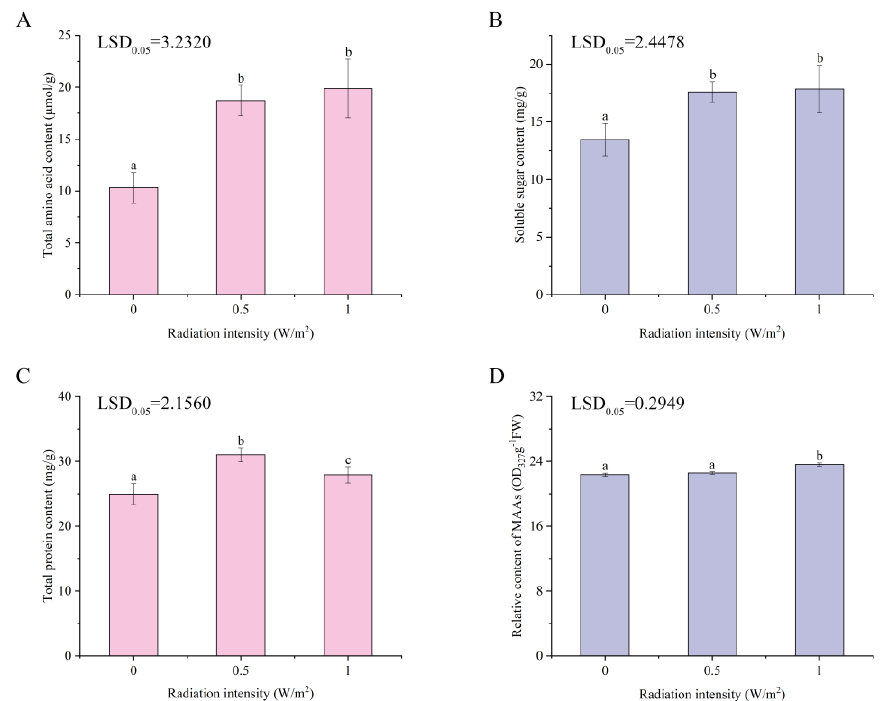
Figure 2. Changes in total amino acids ( A ), soluble sugar ( B ), total protein ( C ), and MAAs ( D ) content in Porphyra haitanensis under different UV-B radiation intensities. Error bars are standard deviations ( n = 4). Columns with different letters are statistically different ( p < 0.05).